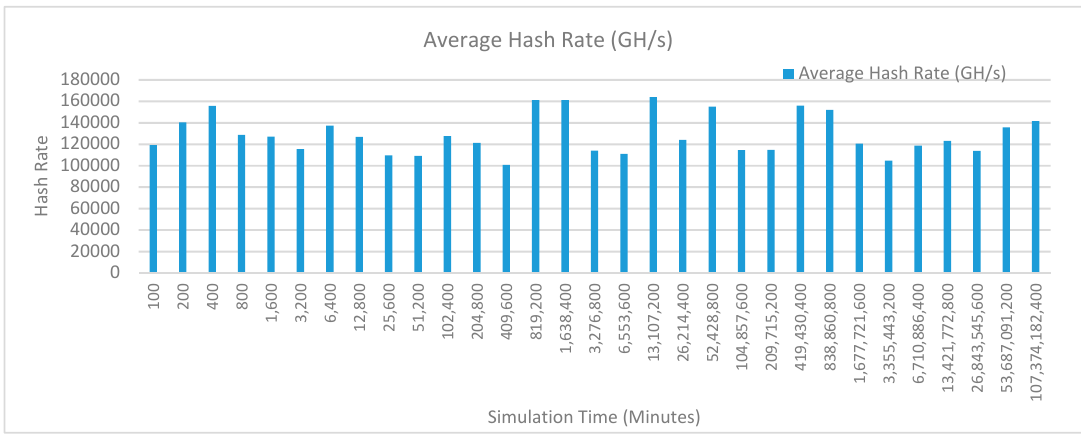
Figure 25. Average hash rate analysis (with IoT, edge, fog).